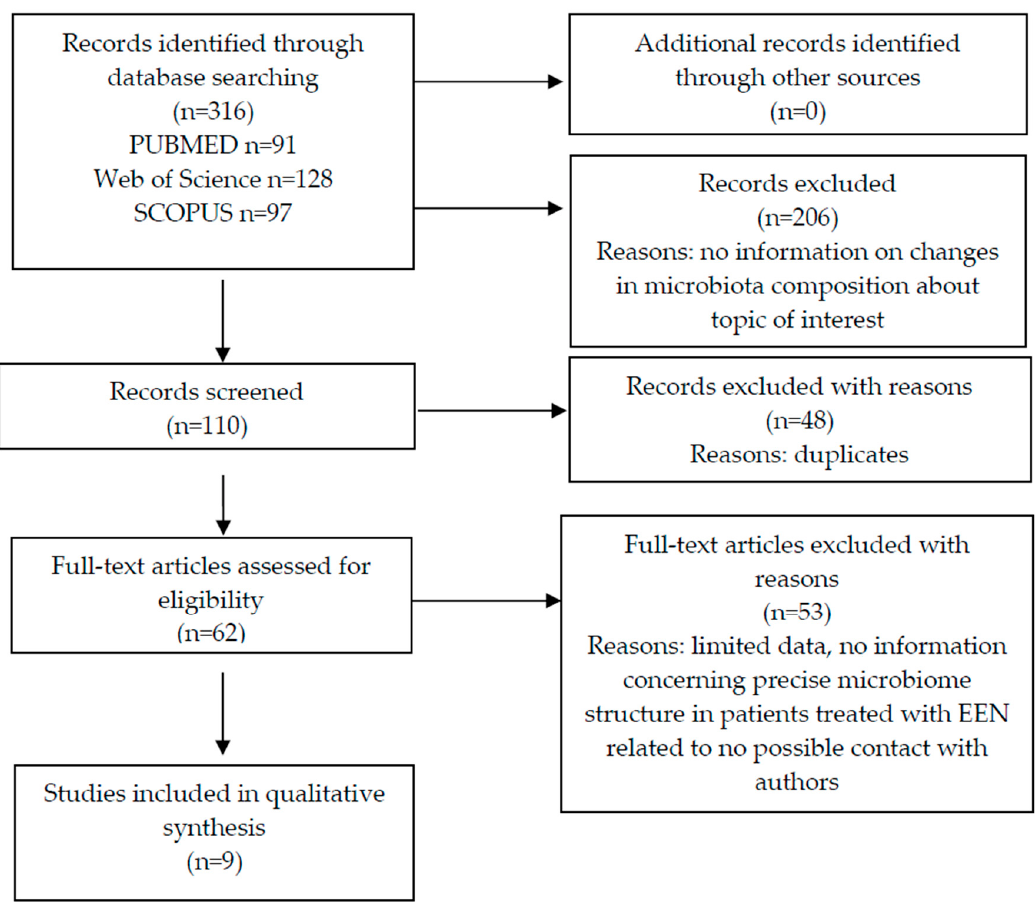
Figure 1. Flow chart of the databases search on the changes in the gut microbiota during exclusive enteral nutrition